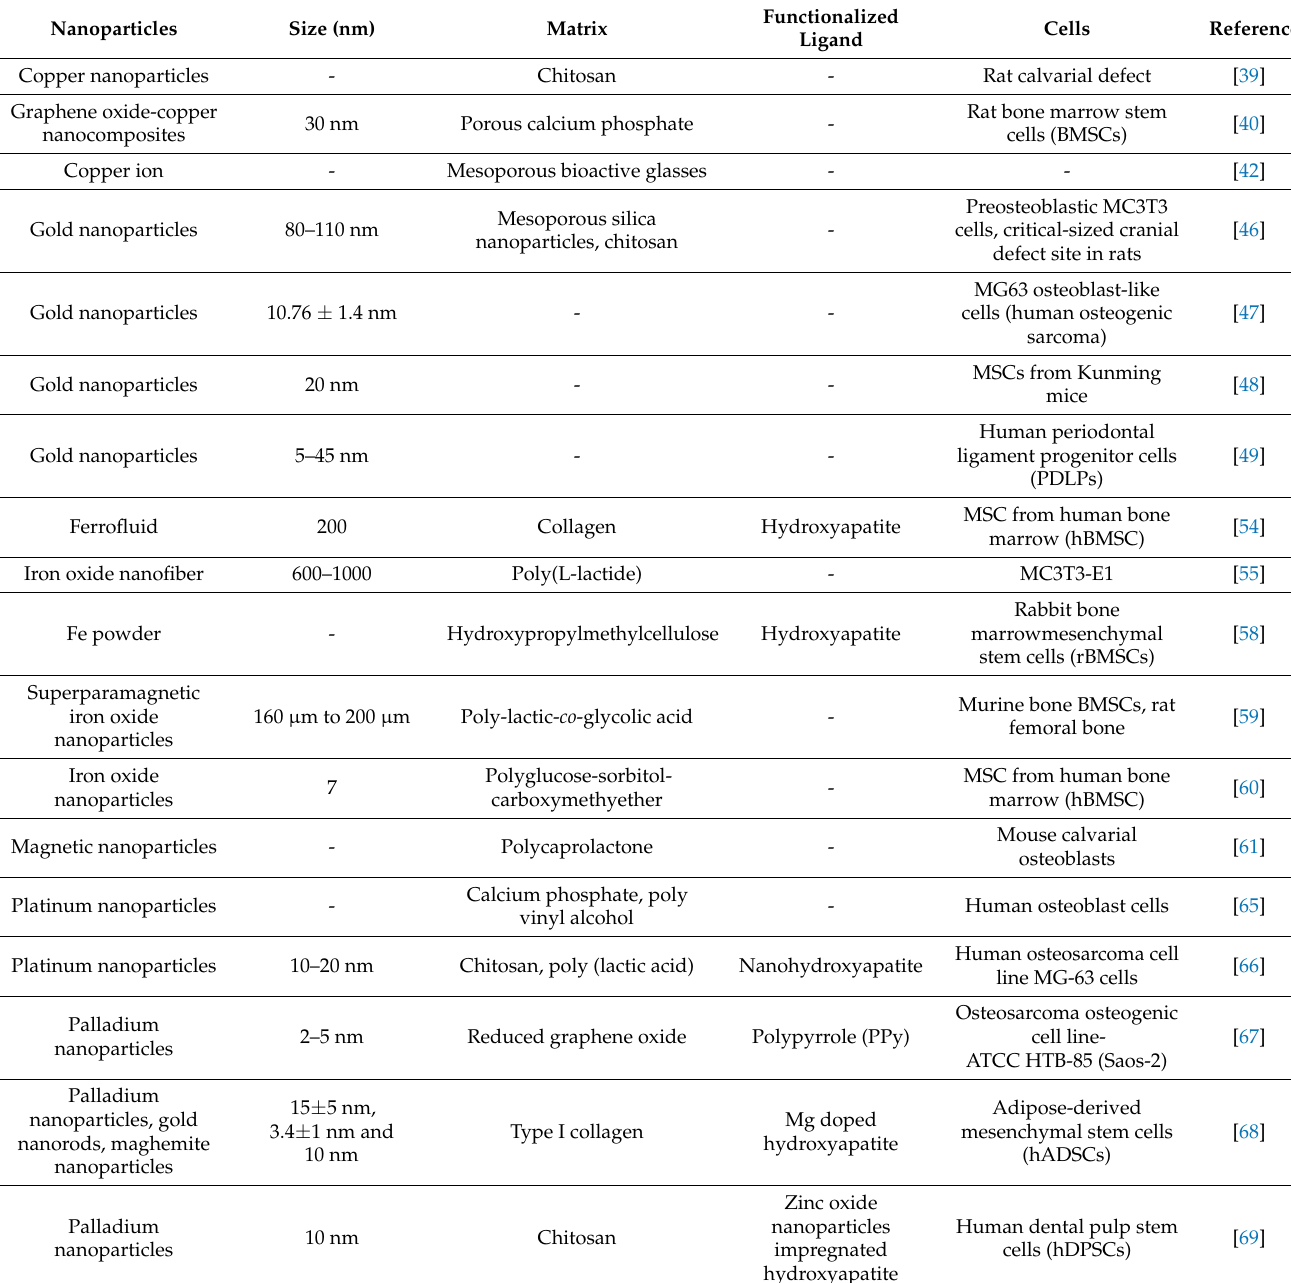
Table A1. Metal based nanoscaffolds for bone tissue